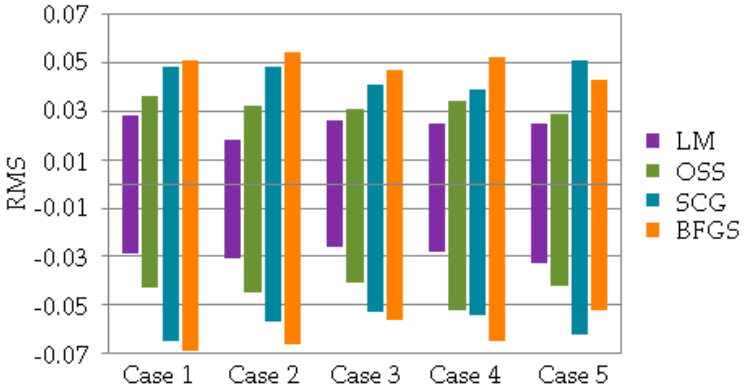
Figure 10. Results of root mean squared errors (RMS) with different learning algorithms. LM— Levenberg–Marquardt; OSS—one-step secant; SCG—scaled conjugate gradient; BFGS—Broyden– Fletcher–Goldfarb–Shanno.